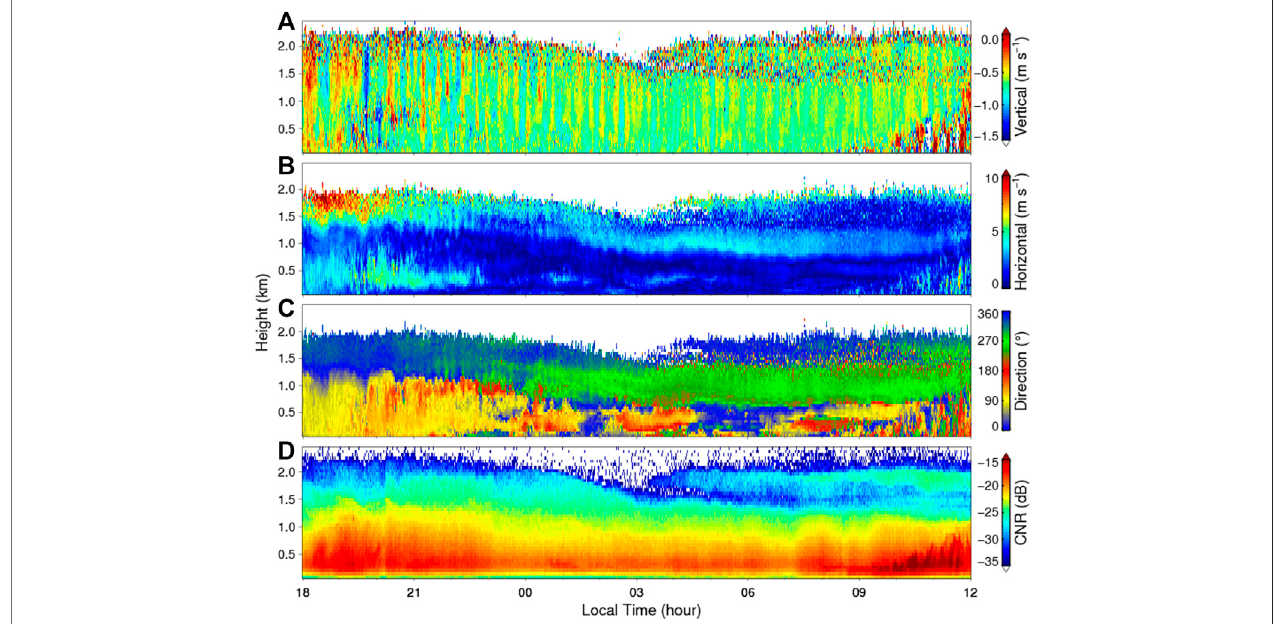
FIGURE 9| A case of gravity wave process detected by C-DWL. (A) Vertical wind, (B) horizontal wind speed, (C) horizontal wind direction, and (D) CNR in vertical obtained by the CDL.